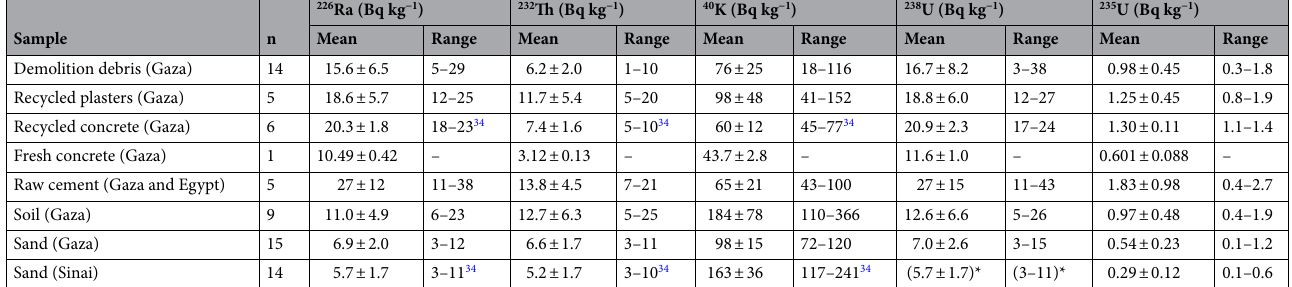
Table 2. The mean and range of activity concentrations of 226 Ra, 232 Th, 40 K, 238 U and 235 U in the analyzed samples. n: number of analyzed samples. ± : standard deviation. Fresh concrete (Gaza): ± indicates combined uncertainty. *Unable to determine 238 U due to the low activity concentration of 238 U and low efficiency of the used detector at low energy area. The activity concentrations are presented using the results of 226 Ra.